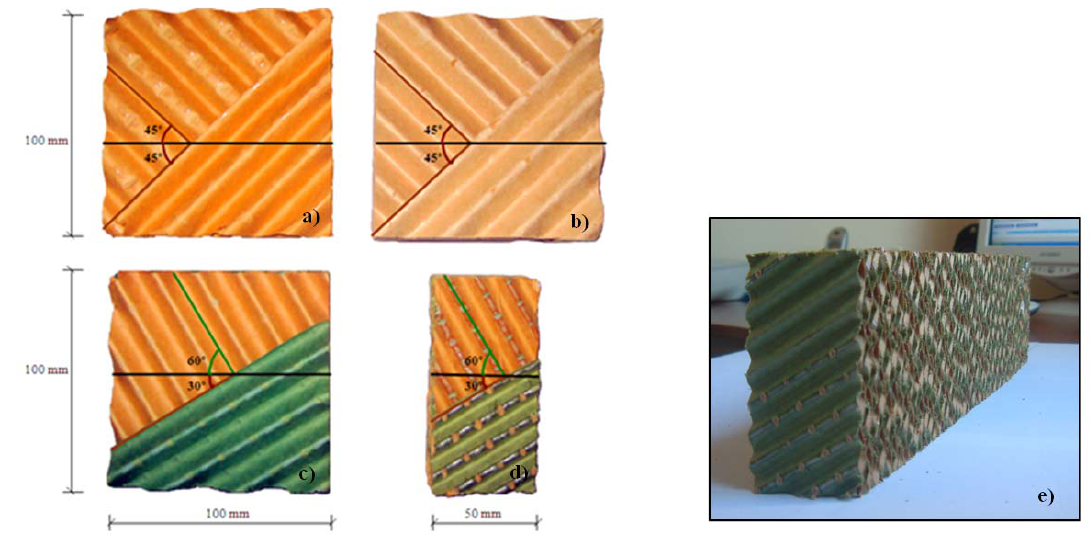
Figure 4. Close-up of the angles of incidence of the 4 cellulose evaporative pads tested: